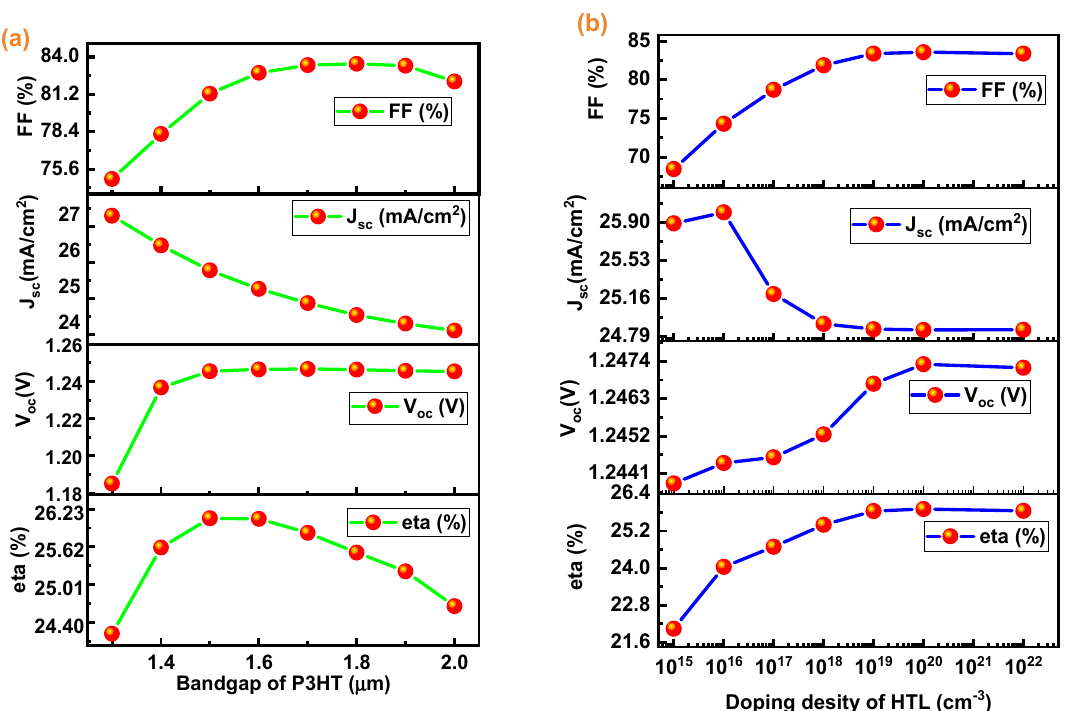
Figure 6. ( a ) Effect of bandgap of P3HT on solar cell parameters (J sc , V oc , FF, and η ] ( b ) Effect of the HTL doping density on the parameters of solar cell (Jsc, Voc, FF, and η ).